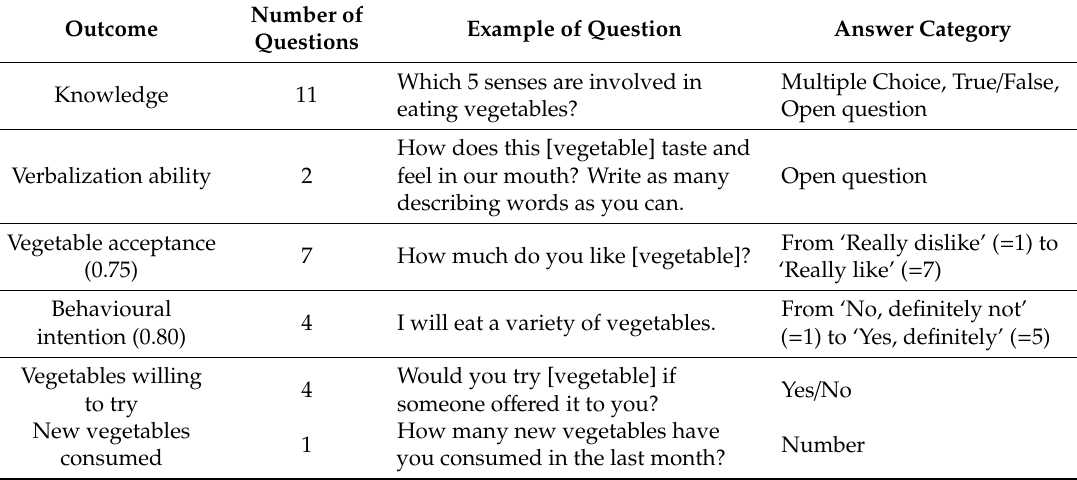
Table 1. Primary outcome variables (Cronbach α ), number and example of question format and answer